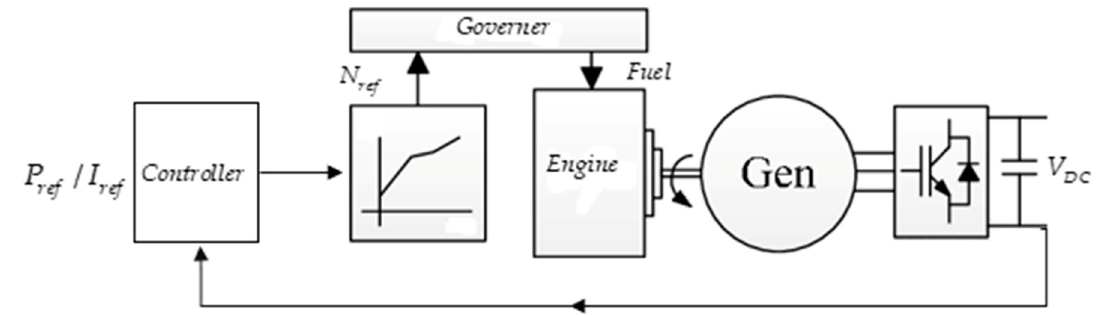
Figure 9. VSDG Figure 9. VSDG architecture.